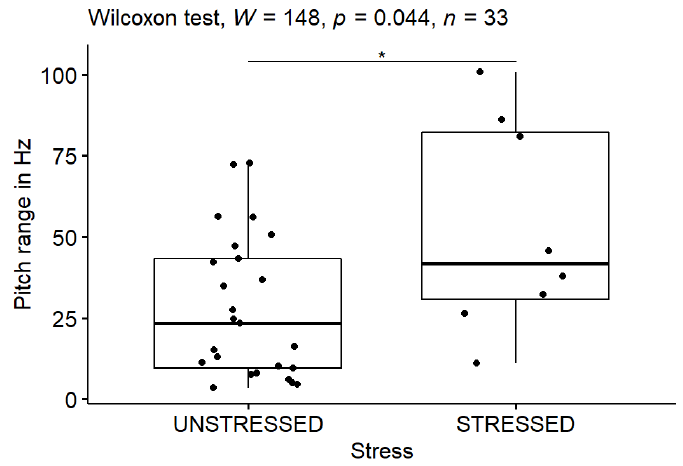
Figure 3. Boxplot for pitch range grouped by stress .